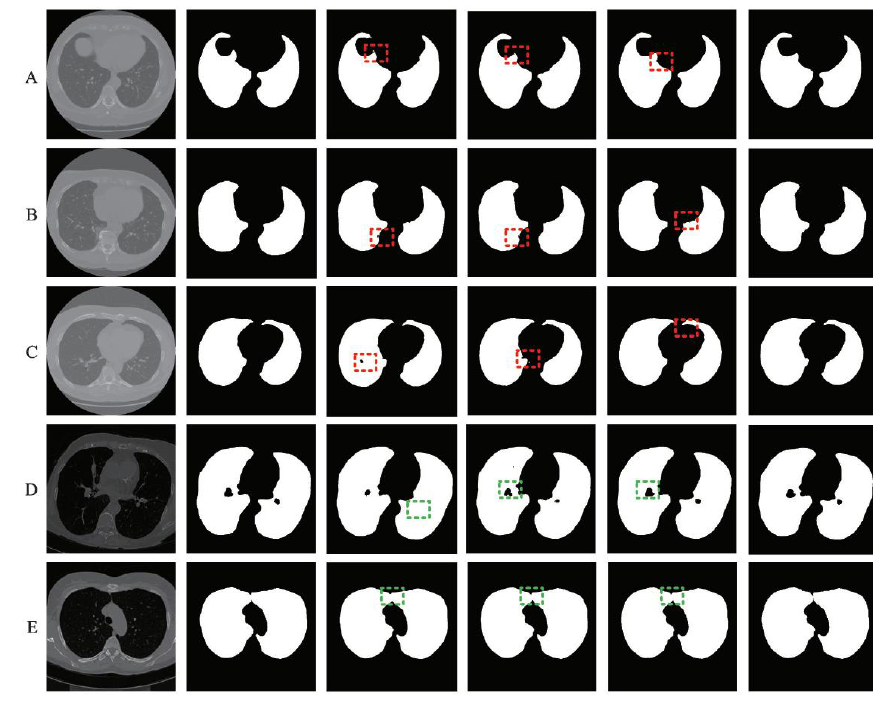
Fig. 6. Segmentation results with different